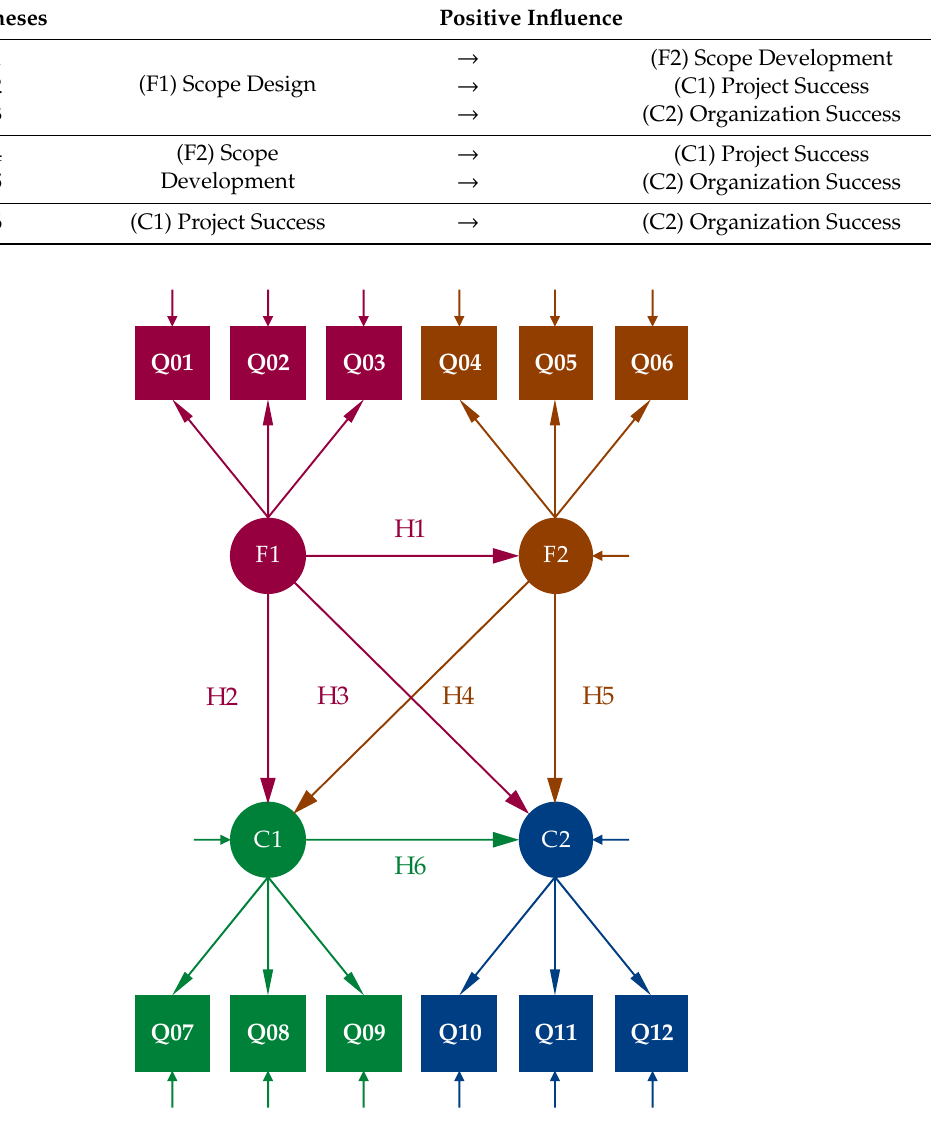
Figure 7. Structural components.